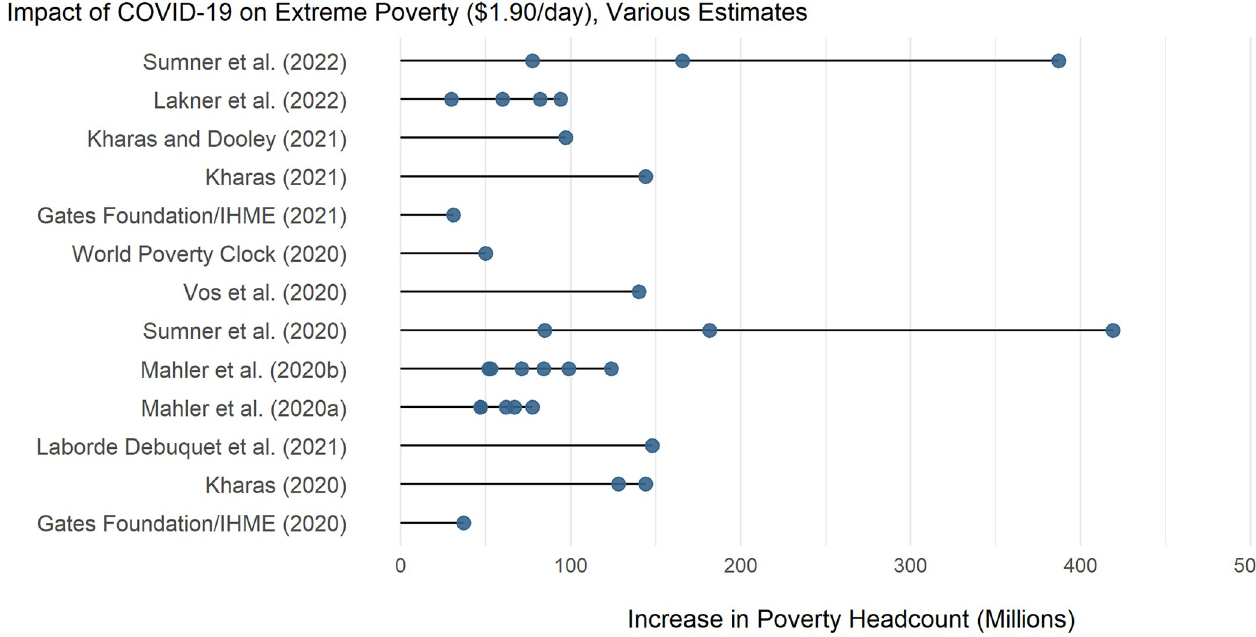
Fig 1. The effect of COVID-19 on poverty: Early estimates from grey literature in millions. If no impact year was specified in the original study, it was assumed that the year assessed for the impact of COVID-19 was the year of study publication.